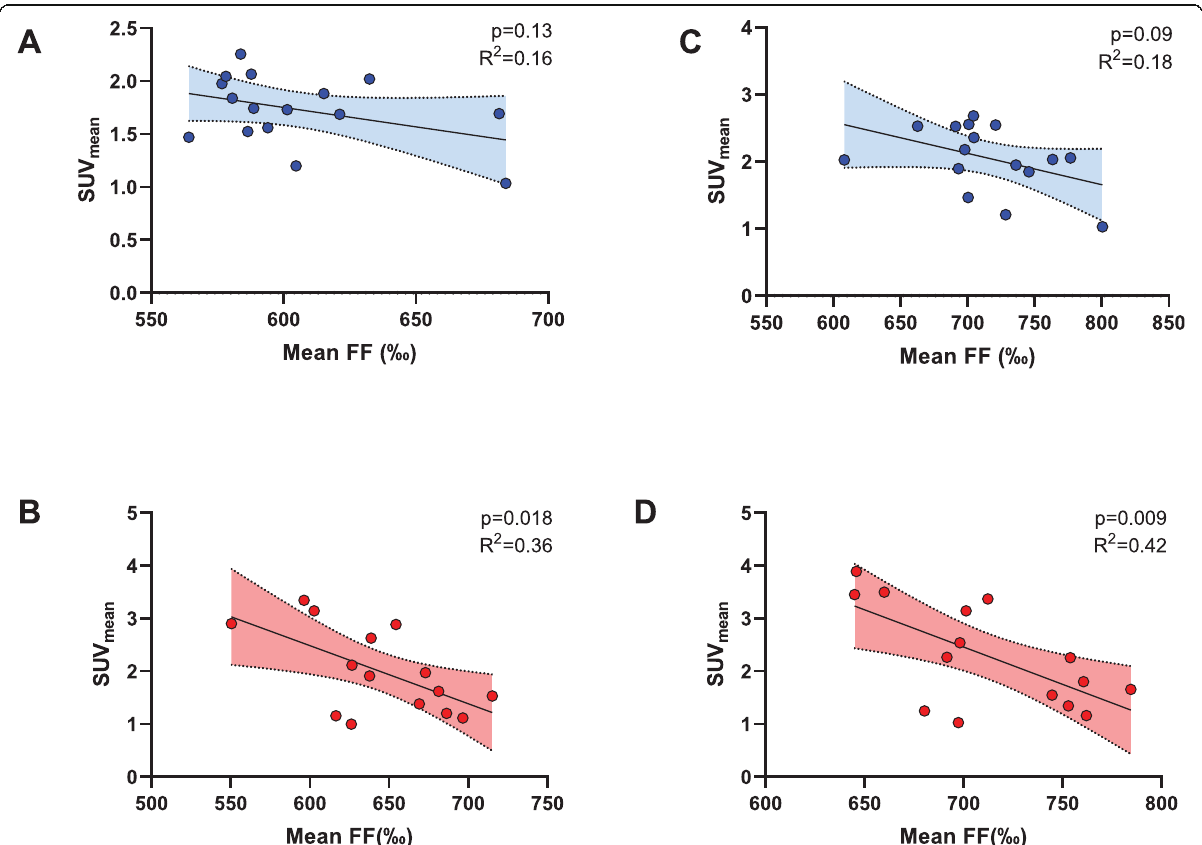
Fig. 4 Simple linear regression plots with SUV mean (g/ml) as dependent variable versus tissue fat fraction ( ‰ ) as the independent variable. Cohort 1, final segmentation ( a ) and the more restrictive optimized final segmentation ( b ). Cohort 2, final segmentation ( c ) and the more restrictive optimized final segmentation ( d )